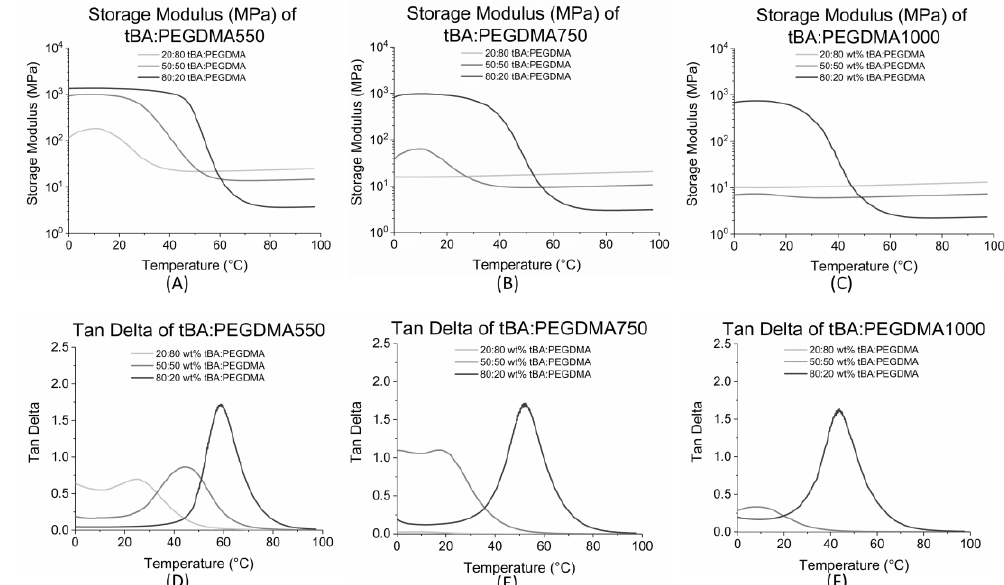
Figure 2. ( A ) Storage Modulus (MPa) of tert-Butyl acrylate (tBA): Poly(ethylene glycol) dimethacrylate (PEGDMA)550; ( B ) Storage Modulus (MPa) of tBA:PEGDMA750; ( C ) Storage Modulus (MPa) of tBA:PEGDMA1000. Glassy regions are absent for the formulations containing 50 wt % tBA or less; ( D ) Tan delta of tBA:PEGDMA550; ( E ) Tan delta of tBA:PEGDMA750; ( F ) Tan delta of tBA:PEGDMA1000. T g increases with increasing tBA content and decreases with increasing PEGDMA MW.